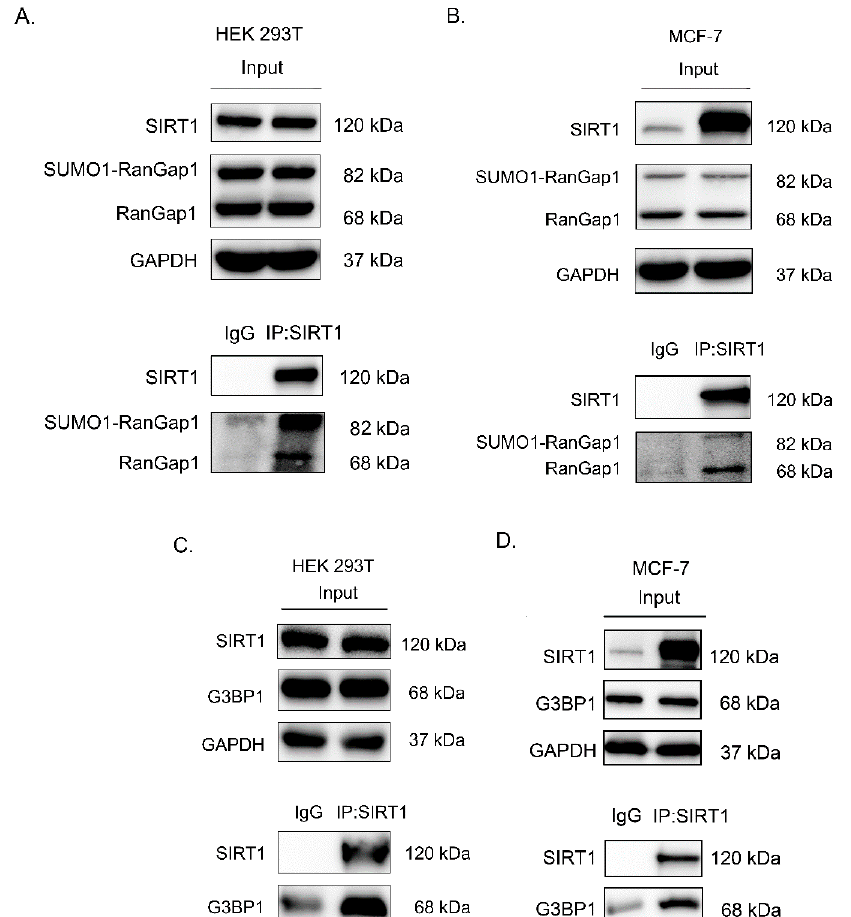
Figure 3. Interaction of SIRT1–RanGap1 and SIRT1–G3BP1 occurs in 2 epithelial cell lines. ( A , C ) SIRT1 interacts with RanGap1 and G3BP1 in HEK 293T cells. ( B , D ) SIRT1 interacts with RanGap1 and G3BP1 in MCF-7 cells. The independent experiments were repeated at least three times. IgG was used as a negative control.